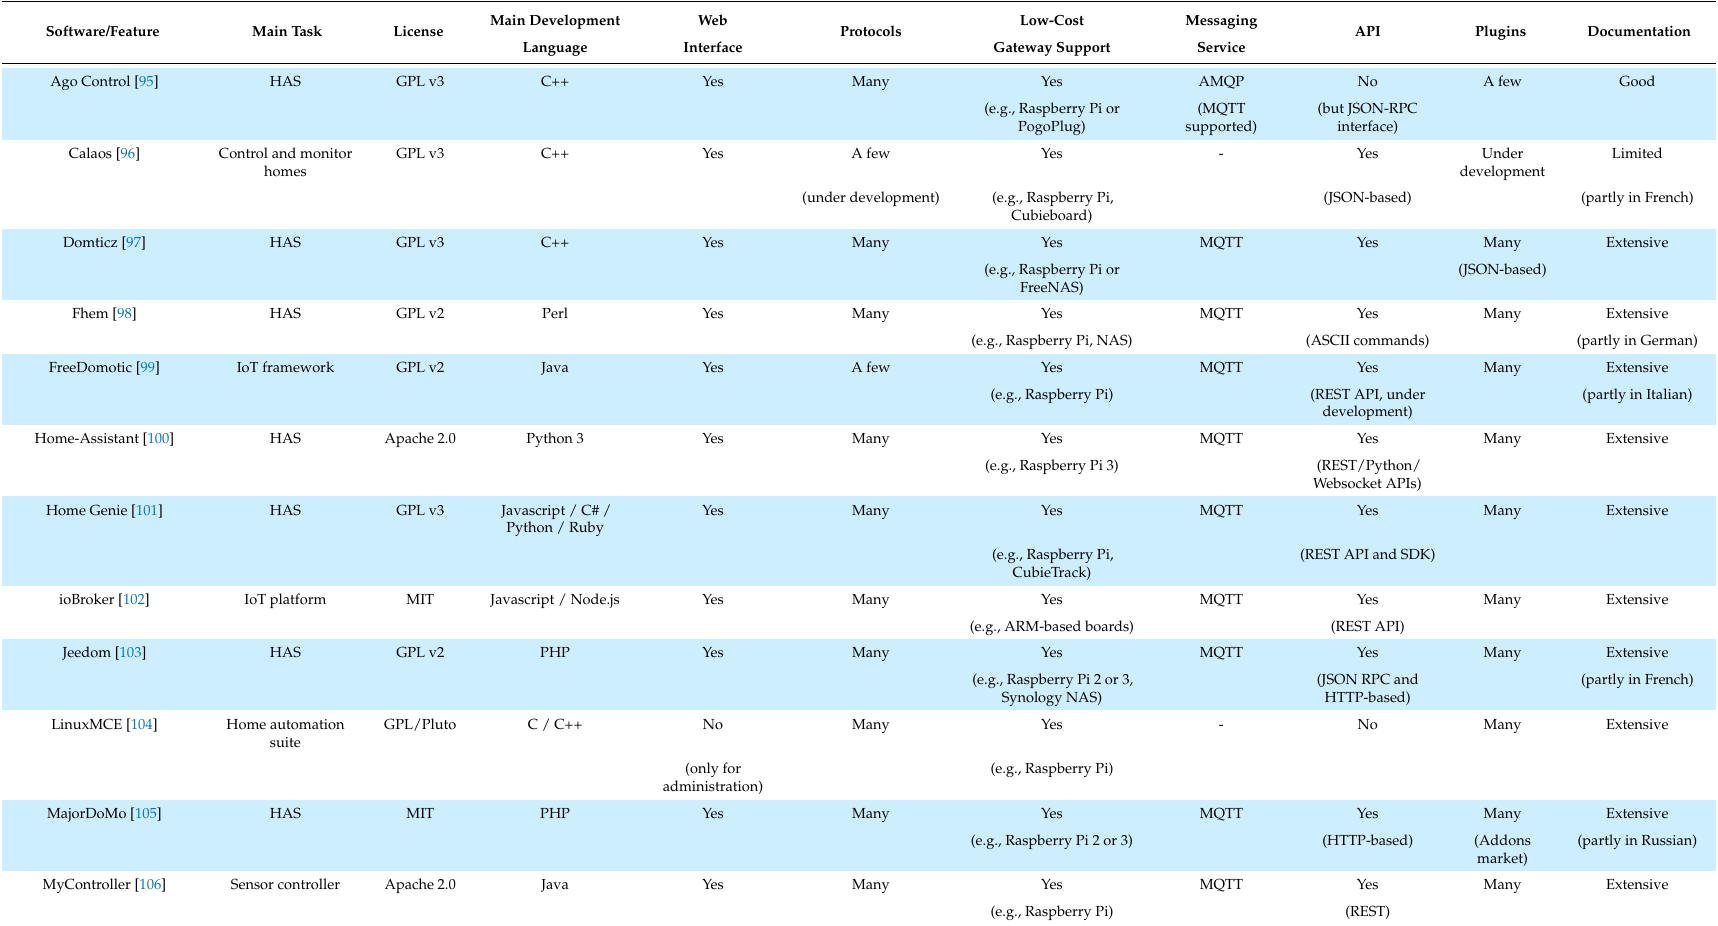
Table 5. Feature comparison of the most relevant open-source home automation